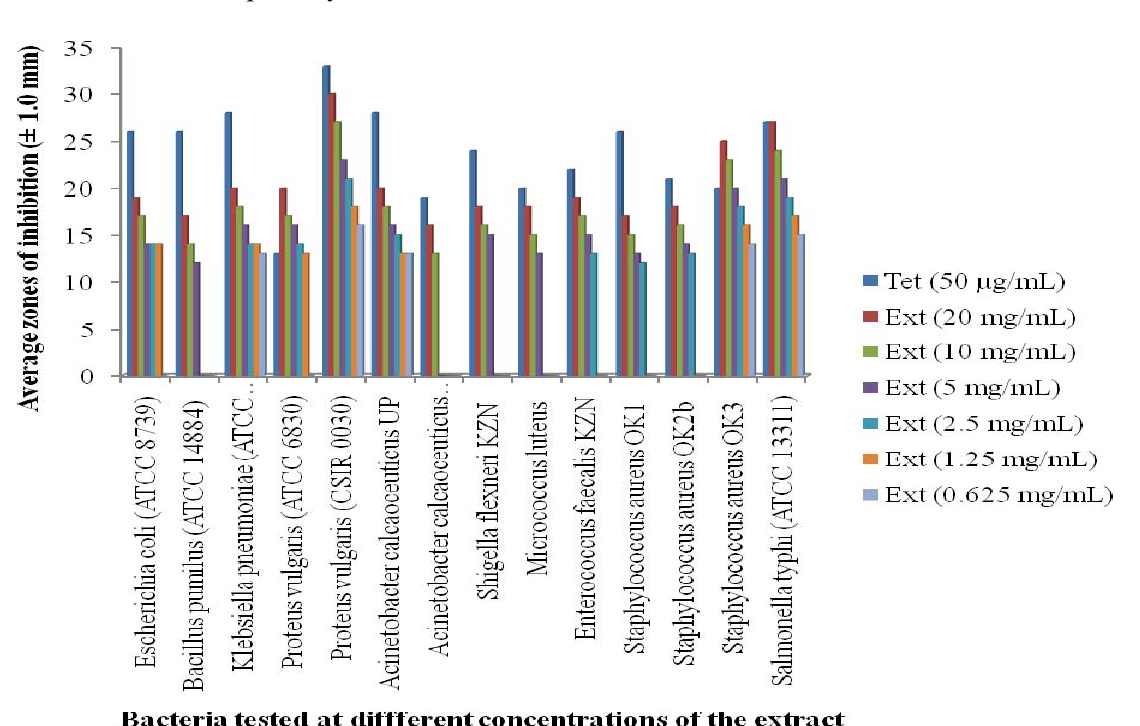
Figure 1. Bacterial susceptibility to different concentrations of crude methanolic extract of A. mearnsii .